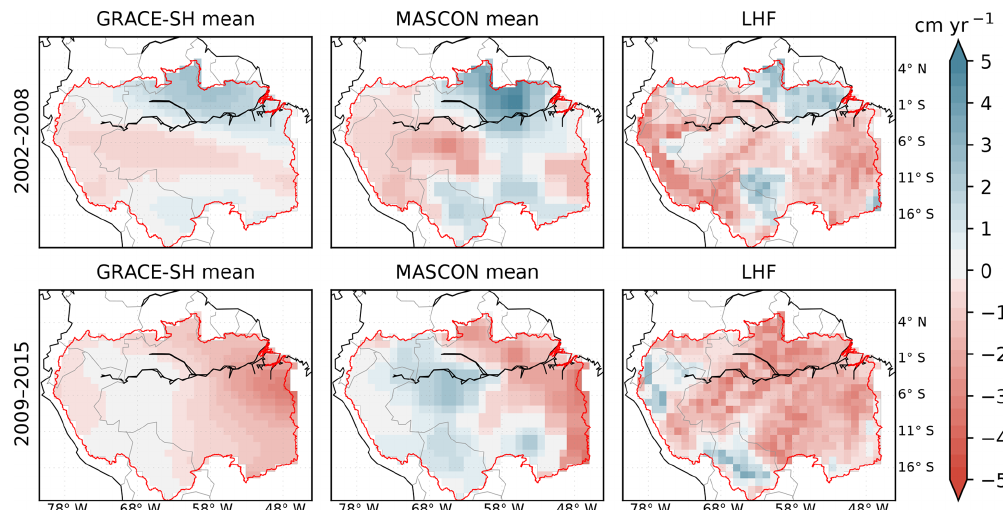
Figure 3. Temporal trend of GRACE solutions compared to the trend in simulated TWS from LHF for the Amazon River basin for two different time periods. GRACE-SH trends displayed are mean trends computed from water thickness anomalies obtained from CSR, GFZ, and JPL processing centers, whereas the mascon mean trend is computed from anomalies obtained from CSR and JPL